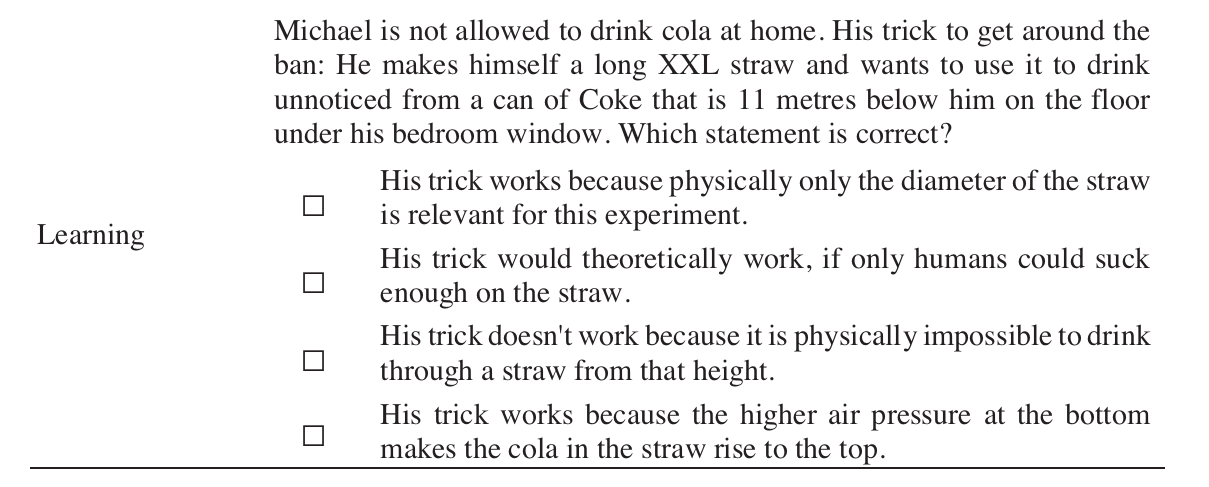
FIG. 6. Example items from used